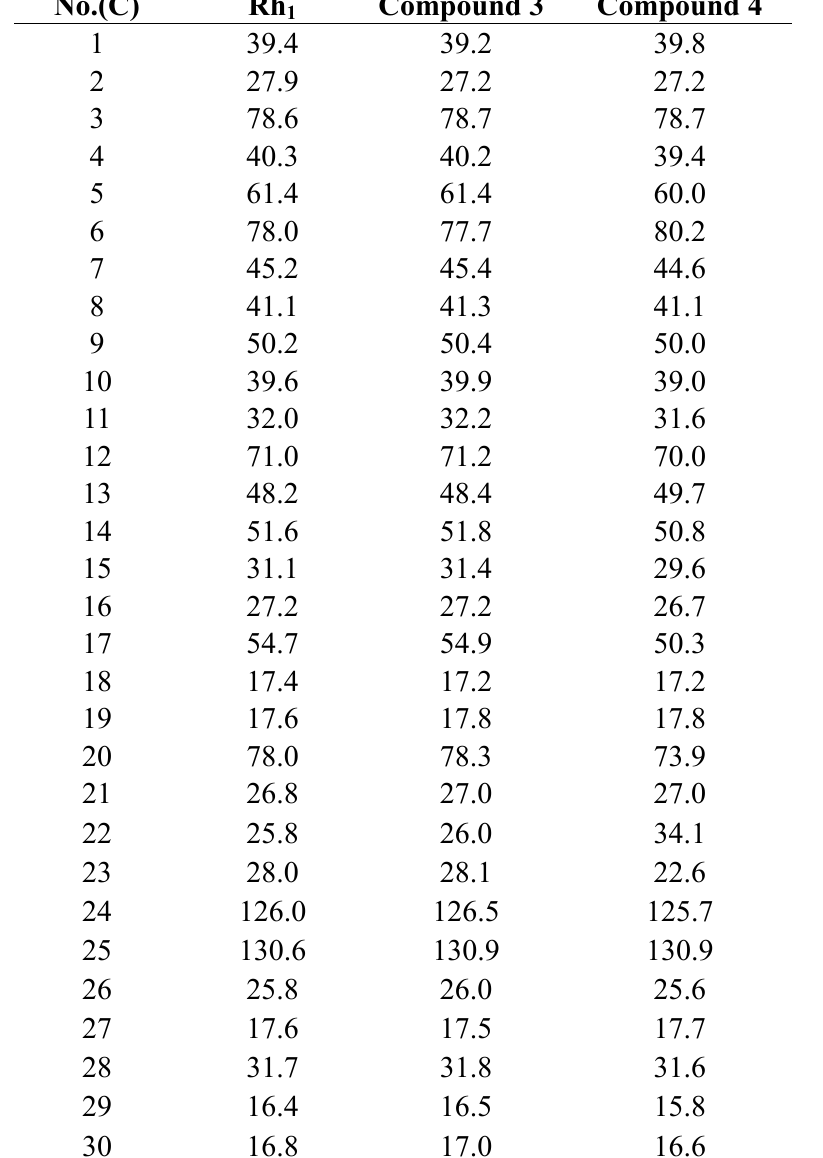
Table 1. 13 C-NMR Chemical Shifts( δ ) of protopanaxatriol and compounds 3 and 4 . a